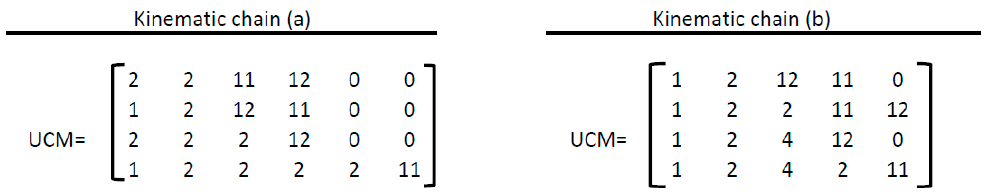
Figure 12. Unified chain matrix for the kinematic chain in Figure 11a,b.